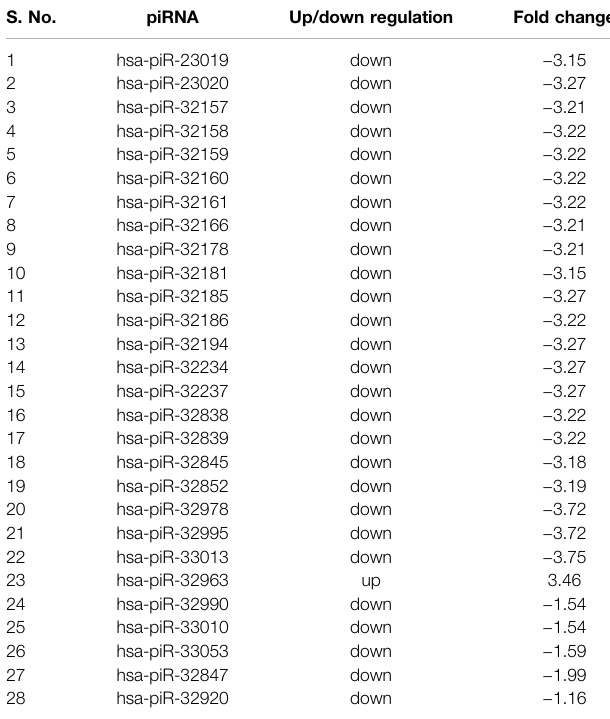
TABLE 3 | Differentially expressed piRNAs in CLL